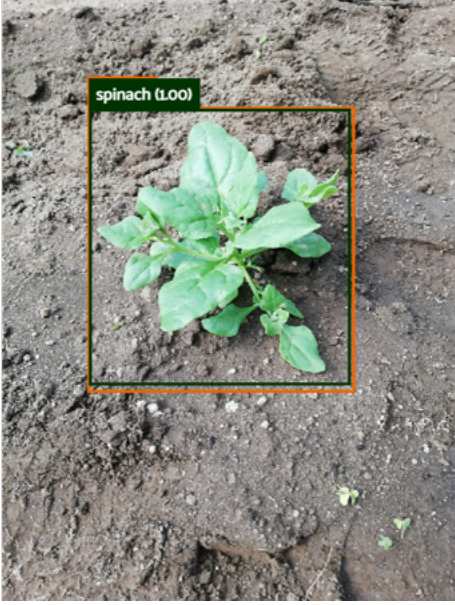
Figure 6. Spinach phenophase prediction made by SSD ResNet 50 based on RGB images. The spinach phenophase describes a spinach plant with less than nine unfolded leaves.